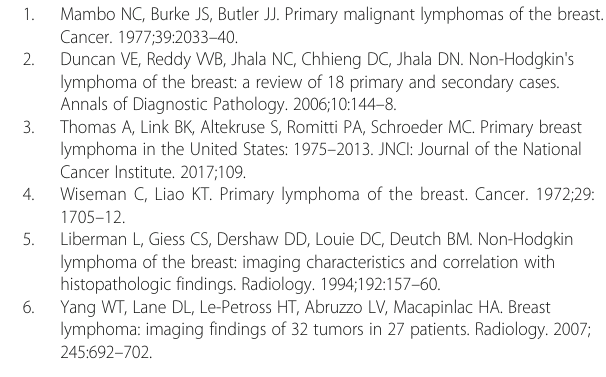
Abbreviations B-LBL: B cell lymphoblastic lymphoma; DLBCL: Diffuse large B cell lymphoma; LBL: Lymphoblastic lymphoma; PBL: Primary breast lymphoma; T-LBL: T cell